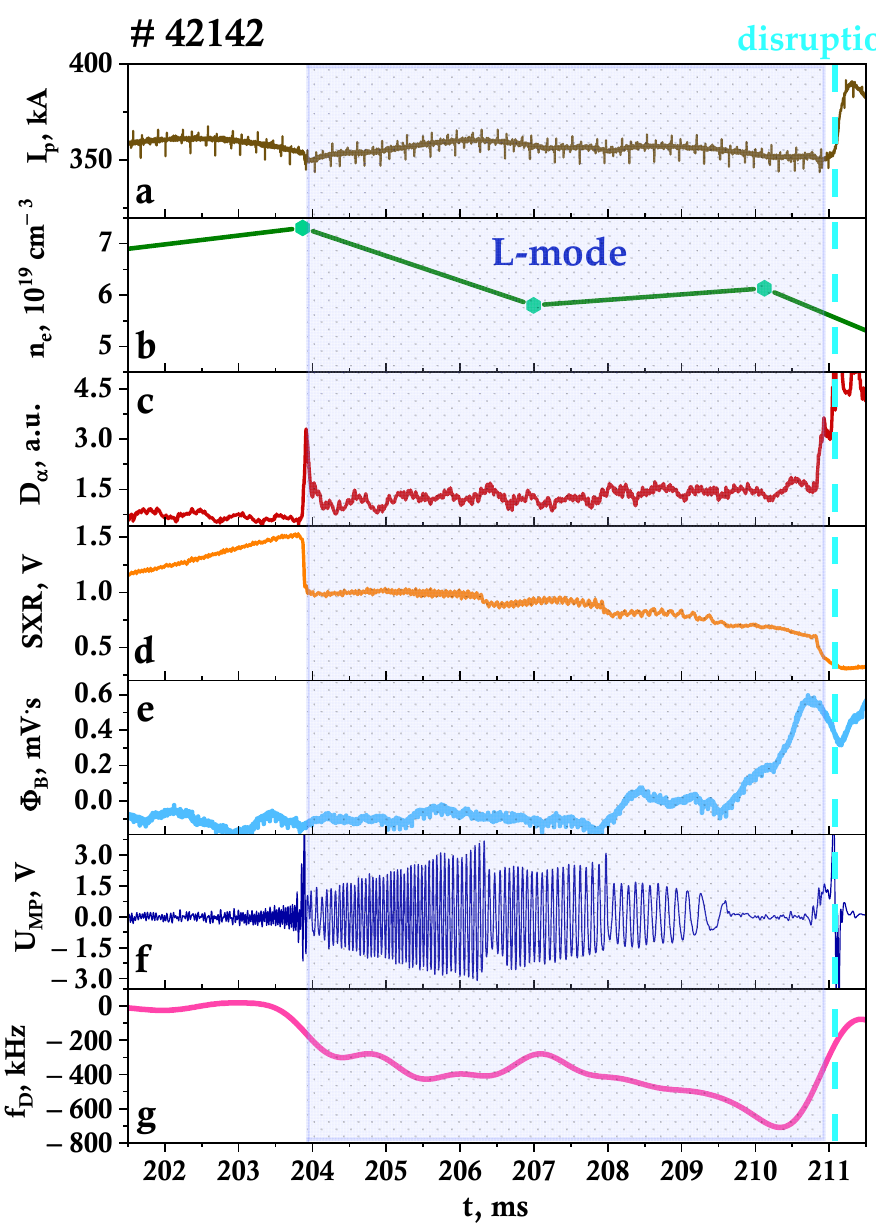
Figure 8. The Globus-M2 plasma parameters for discharge #42142: ( a ) plasma current I p , ( b ) electron density n e , ( c ) D α signal, ( d ) soft X-ray (SXR) signal, ( e ) locked mode sensor signal Φ B , ( f ) magnetic probe signal U MP , ( g ) Doppler frequency shift f D .